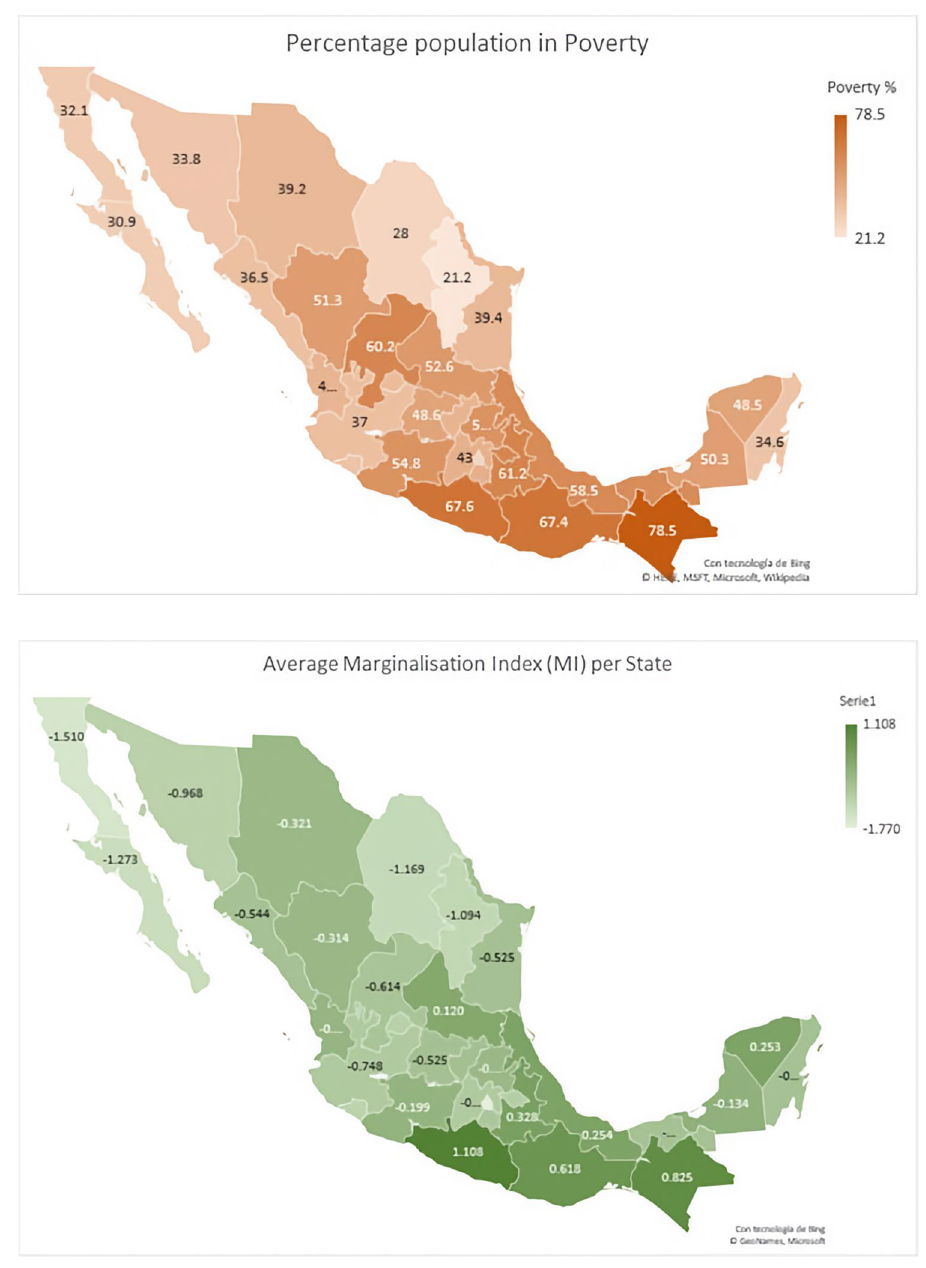
Fig. 8 Poverty percentage in Mexico [Choropleth]